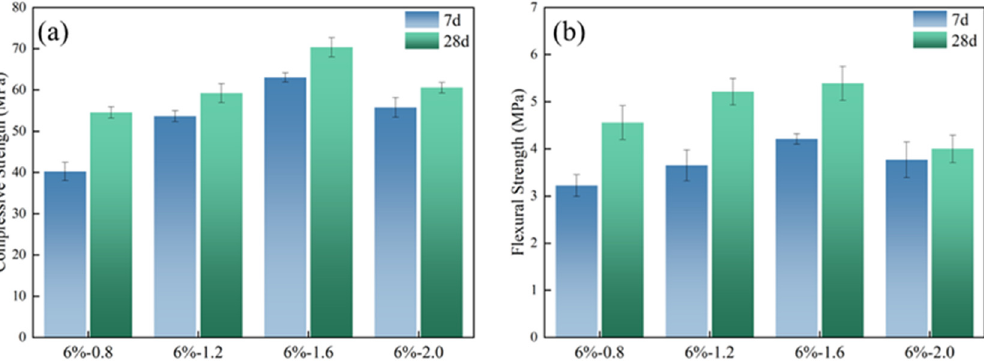
Figure 5. Effect of modulus on mechanical properties of slag-based geopolymer: ( a ) Compressive strength; ( b ) Flexural strength.